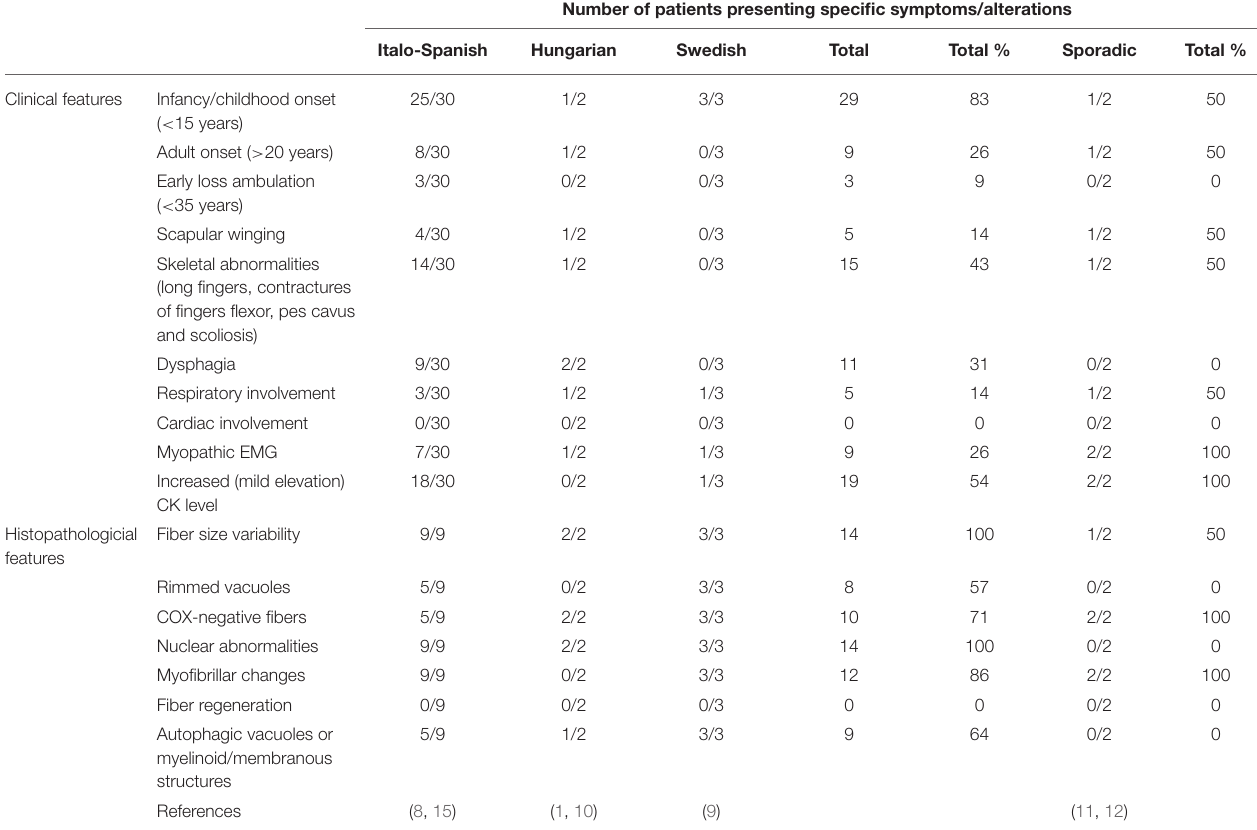
TABLE 1 | Major clinical and histopathological features in the familial and sporadic cases of LGMD D2